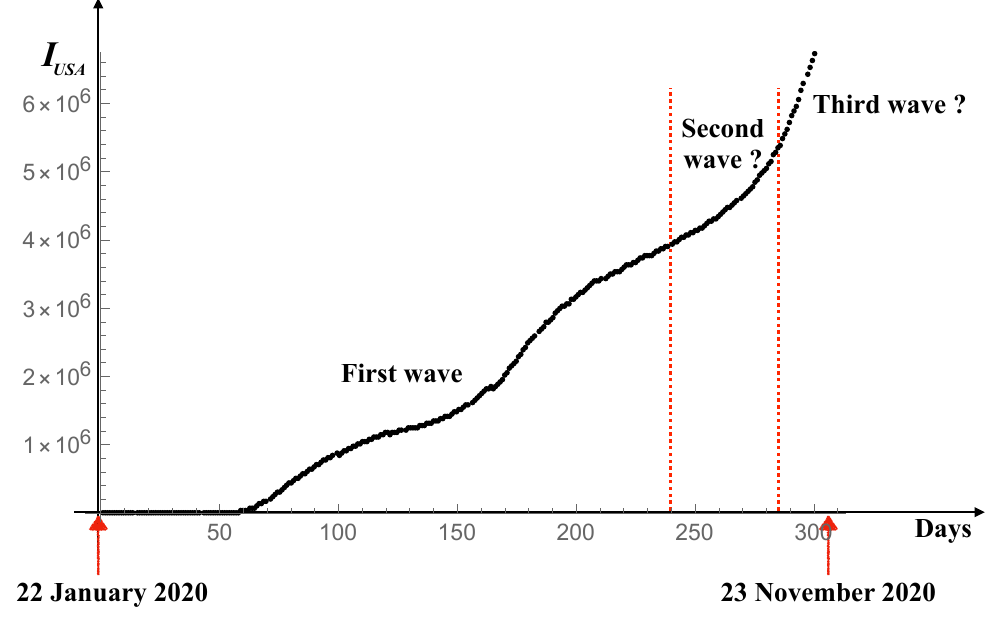
Figure 20. Number of infectious individuals by SARS-CoV-2 in USA.